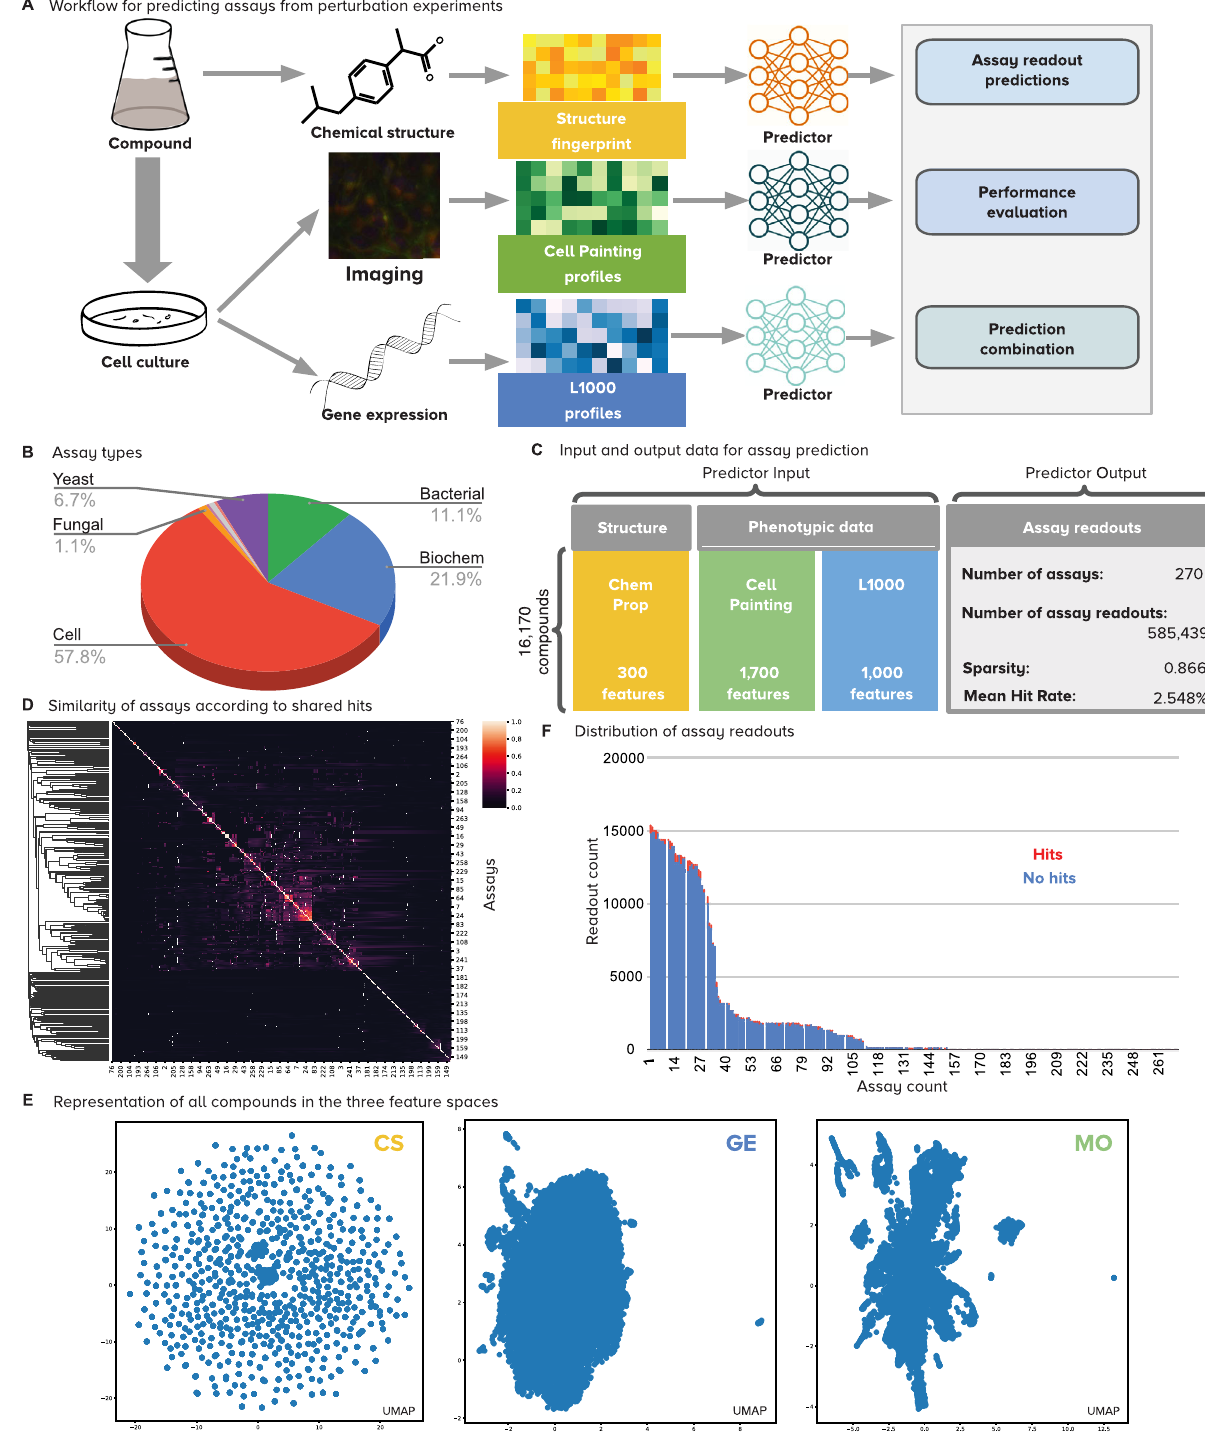
(Supplementary Fig. 13). E UMAP visualizations of all compounds in the three fea- ture spaces evaluated in this study (Supplementary Fig. 10). CS (yellow) Chemical Structure, GE (blue) Gene Expression, MO (green) Morphology. F Distribution of assay readouts for assays in the horizontal axis sorted by readout counts. The available examples follow a long tail distribution and the average ratio of positive hits to tested compounds (hit rate) is 2.548%.